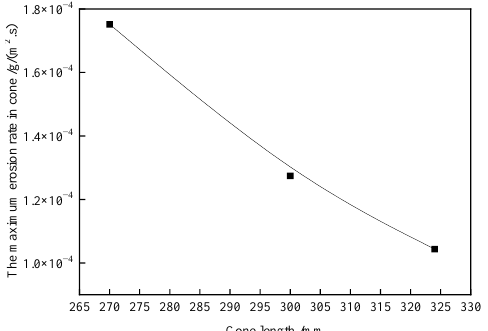
Figure 17. The comparison for the maximum erosion rate of different cone lengths.